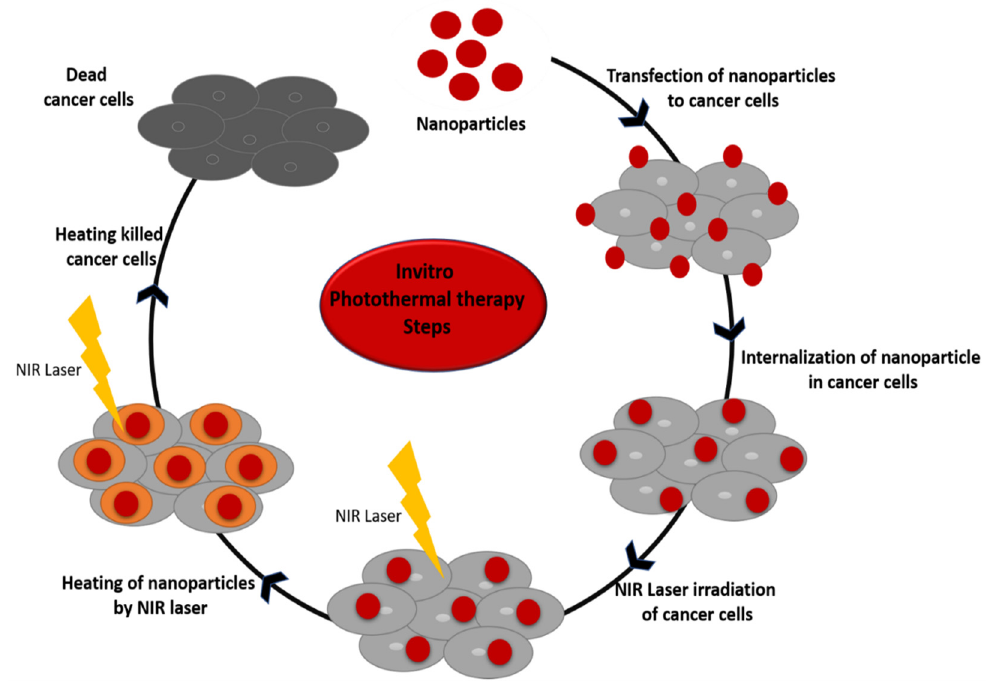
Figure 4. Steps for in vitro photothermal therapy.